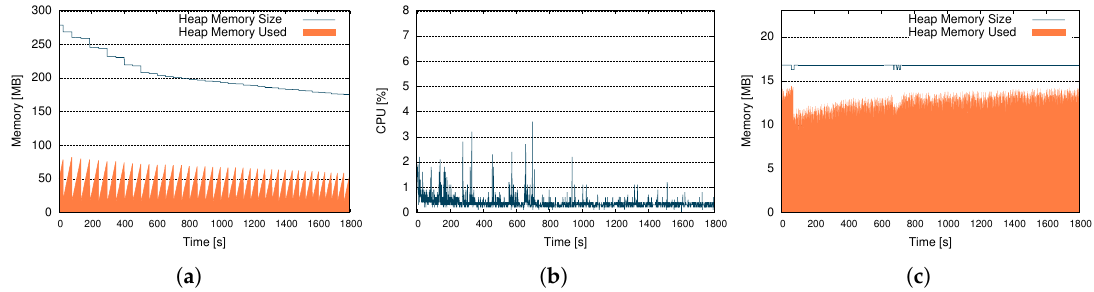
Figure 11. ( a ) Memory usage with the -Xmx256m option ( b ) CPU usage ( c ) memory usage with the -Xmx16m